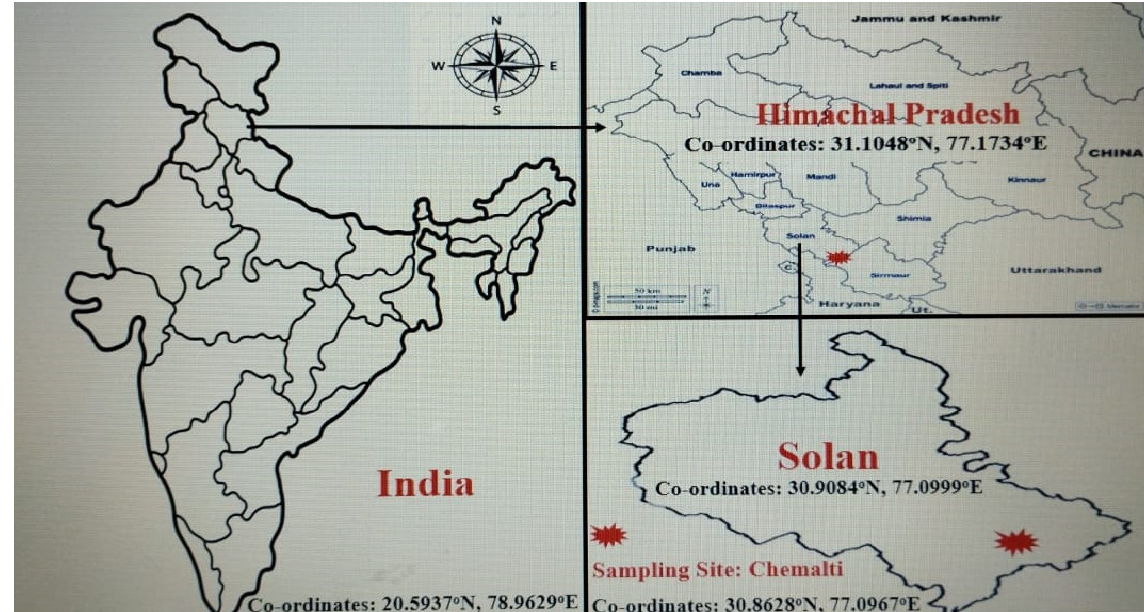
Figure 1. Sampling sites of the study in Solan, Himachal Pradesh, India.